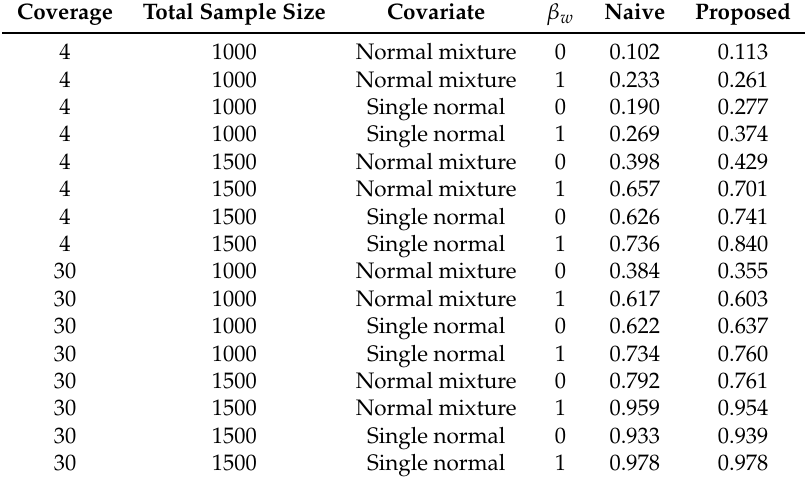
Table 2. Empirical rejection rates under alternative hypothesis. The level of significance was set as 5 × 10 − 8 .